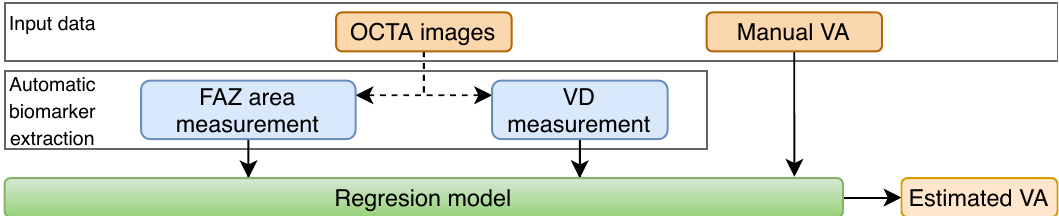
Figure 1. Steps of the presented methodology.